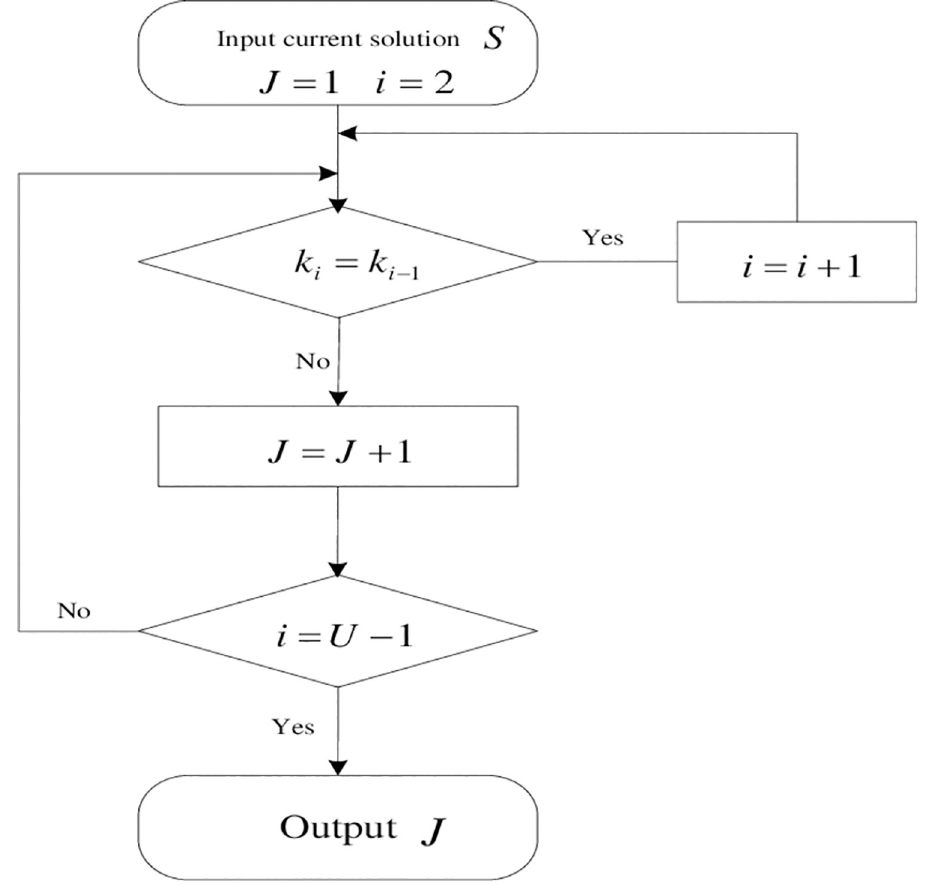
Fig 3. Flow chart of dividing